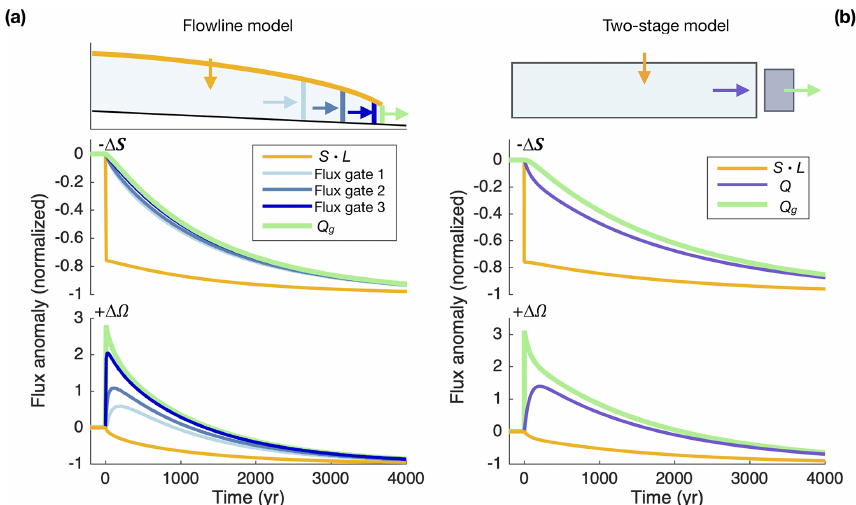
Figure 3. Flux changes following interior vs. ocean forcing. (a) Flowline model flux anomalies to perturbations in S and (cid:127) . The schematic (top) shows the flux gates considered. Below, normalized flux responses to the perturbations are shown for each flux gate. (b) As for (a) but for the two-stage model, which has three flux variables. The two-stage model’s interior flux variable ( Q ) captures the basic tendencies of interior fluxes in the flowline model. In both cases, the response to a perturbation in (cid:127) clearly shows the two-timescale nature of outlet-glacier